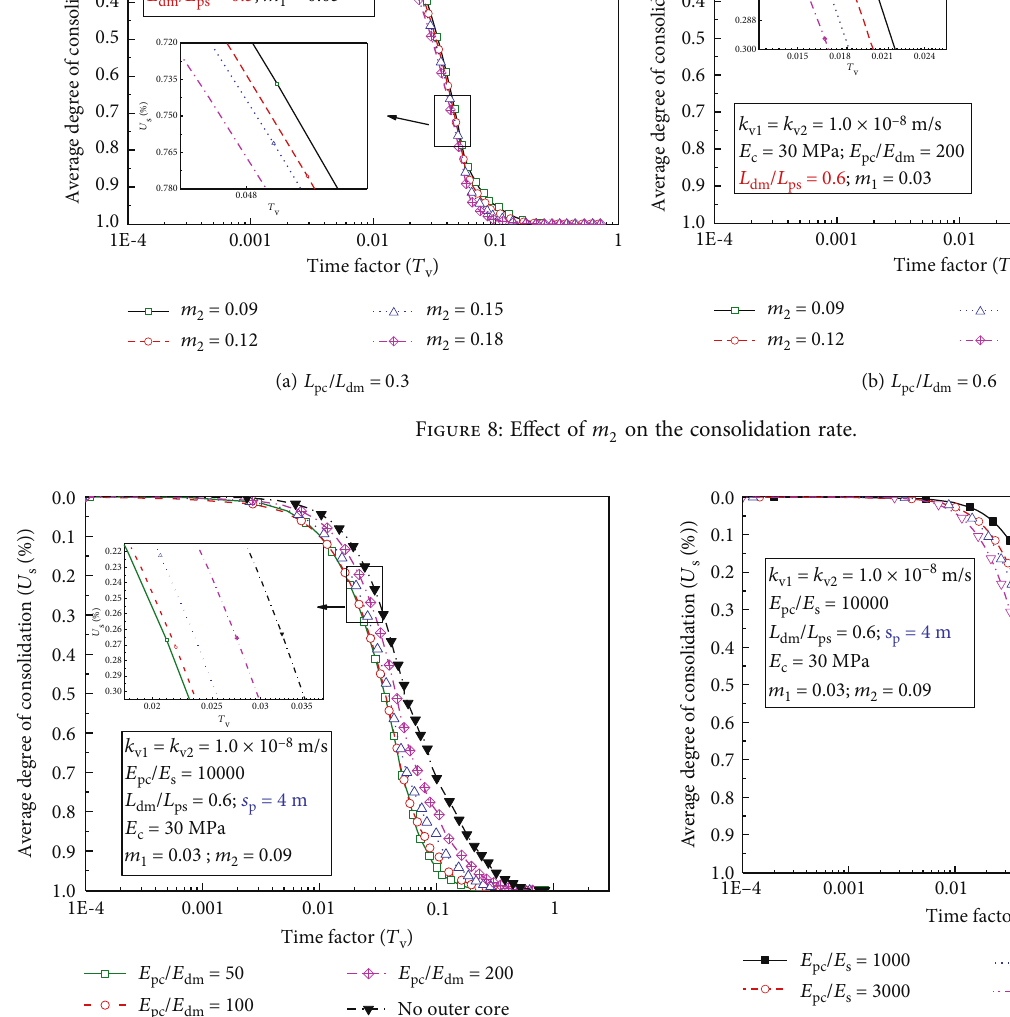
Figure 10: E ff ect of E